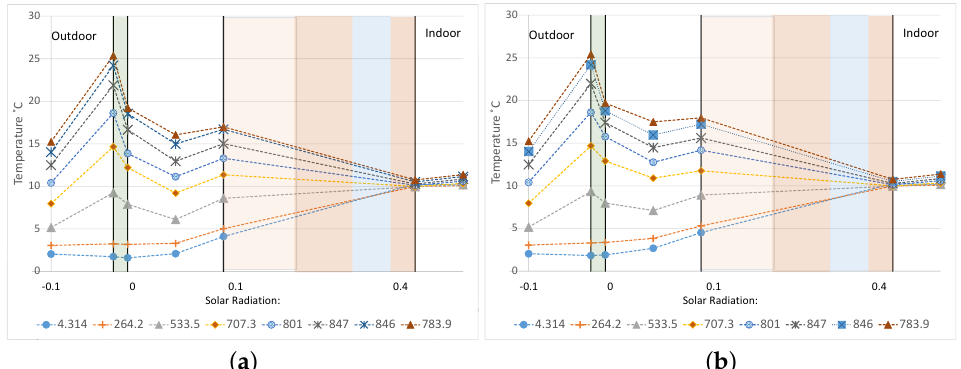
Figure 12. Open ventilation grills. Trend of measured temperature in the different layers of the southern ventilated façade for daily hours with different solar radiation and temperature values under winter conditions (14 January 2021), for: ( a ) Zone 2; ( b ) Zone 4.